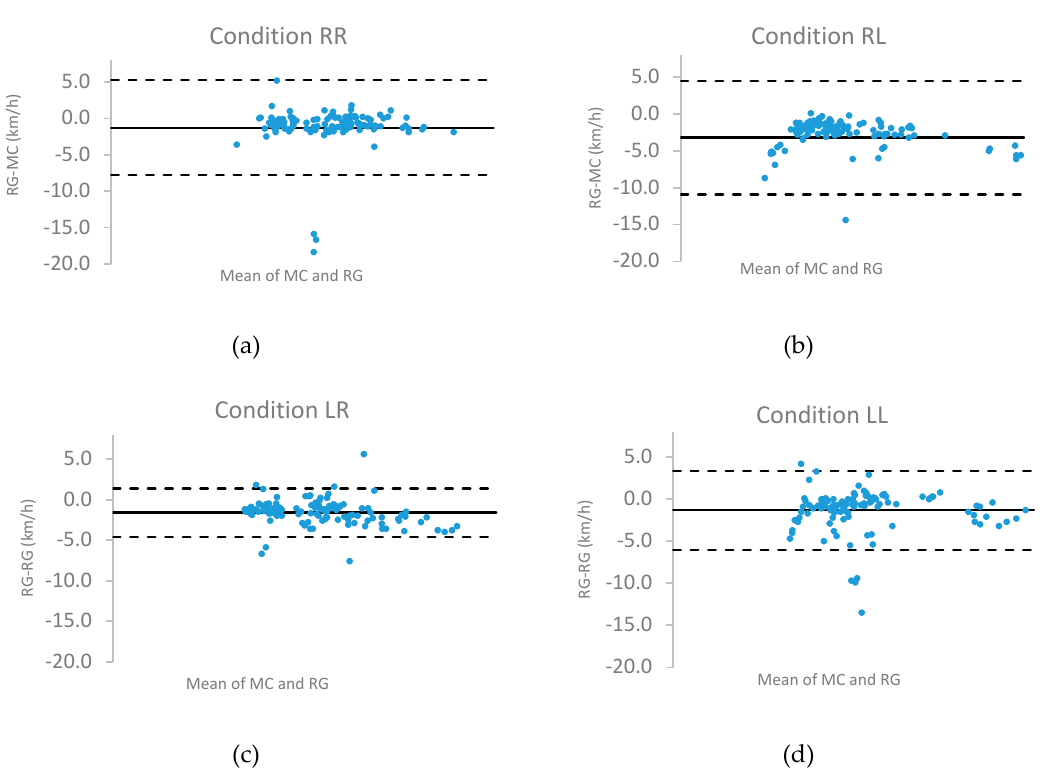
Figure 2. Bland–Altman plots, where dotted lines represent the upper and lower limits of agreement (LOA = mean ± 1.96 × SD) and the solid line represents the mean difference (bias). ( a ) Condition RR ( b ), Condition RL, ( c ) Condition LR, ( d ) Condition